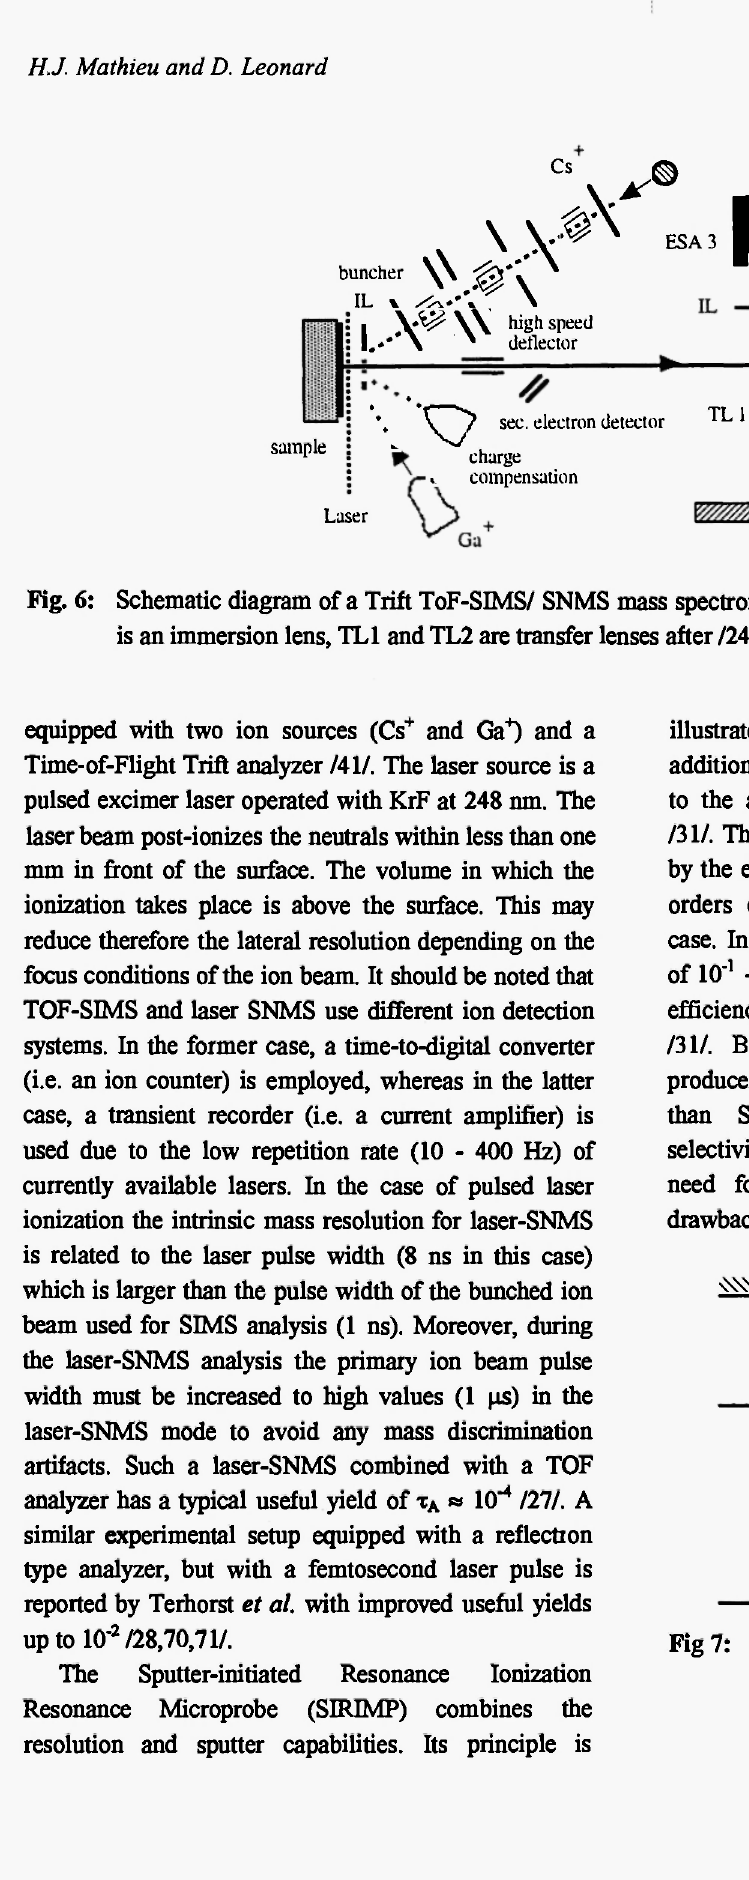
Fig 7: Principle of a resonant two-photon post- ionization (SIRIMP), after /31/. The first step (vl) may be obtained with a tunable dye laser and the second step (v2) with an Excimer